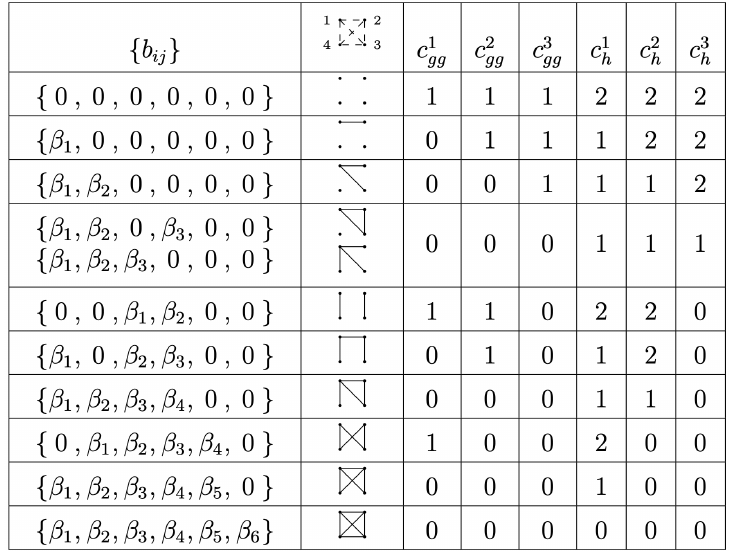
according to [4], showing only inequivalent ij